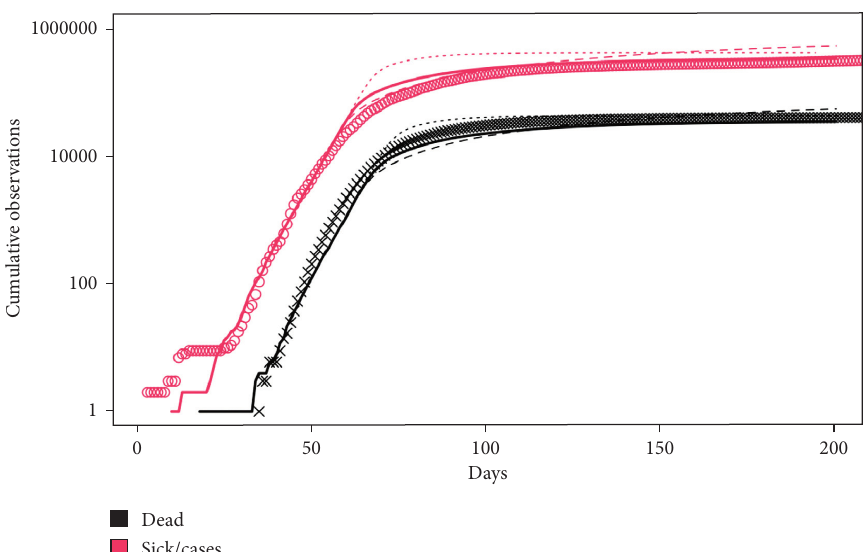
Figure 5: Total number of cases (o) and deaths ( × ) observed in the UK by 31 August 2020 alongside comparable model simulations implementing social distancing at day 48 (– –), 50 (—), and 55 (- - -) with R